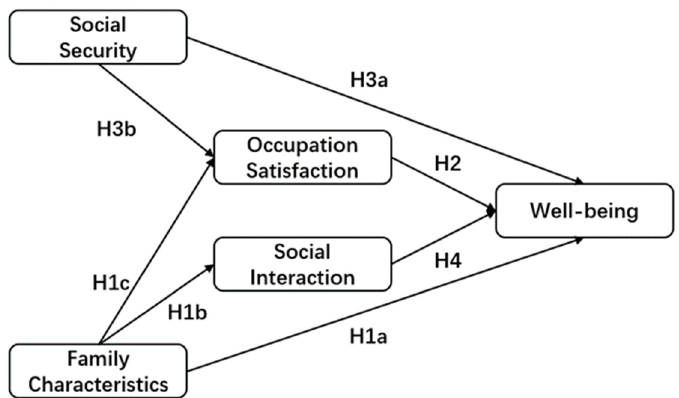
Figure 1. Theoretical Model.